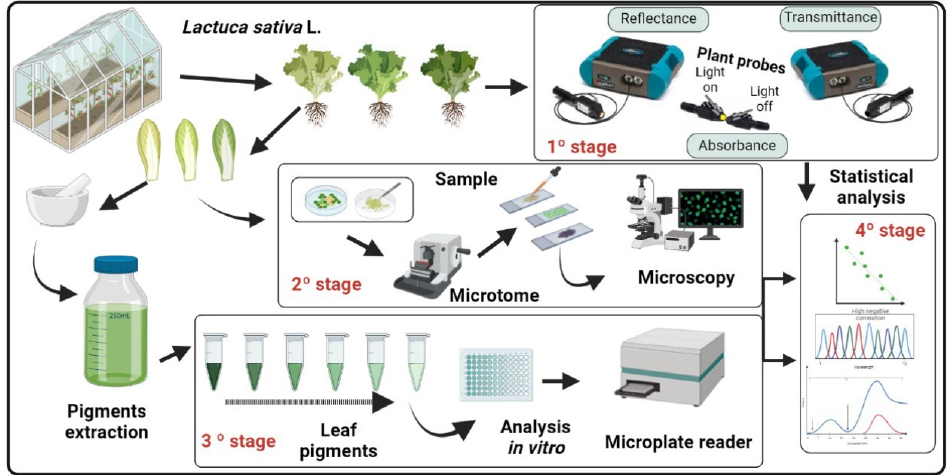
Figure 1. Flowchart of methodology used in data mining and machine learning based on hyperspec- troscopy and anatomical analysis of classification and prediction parameters in green lettuce.